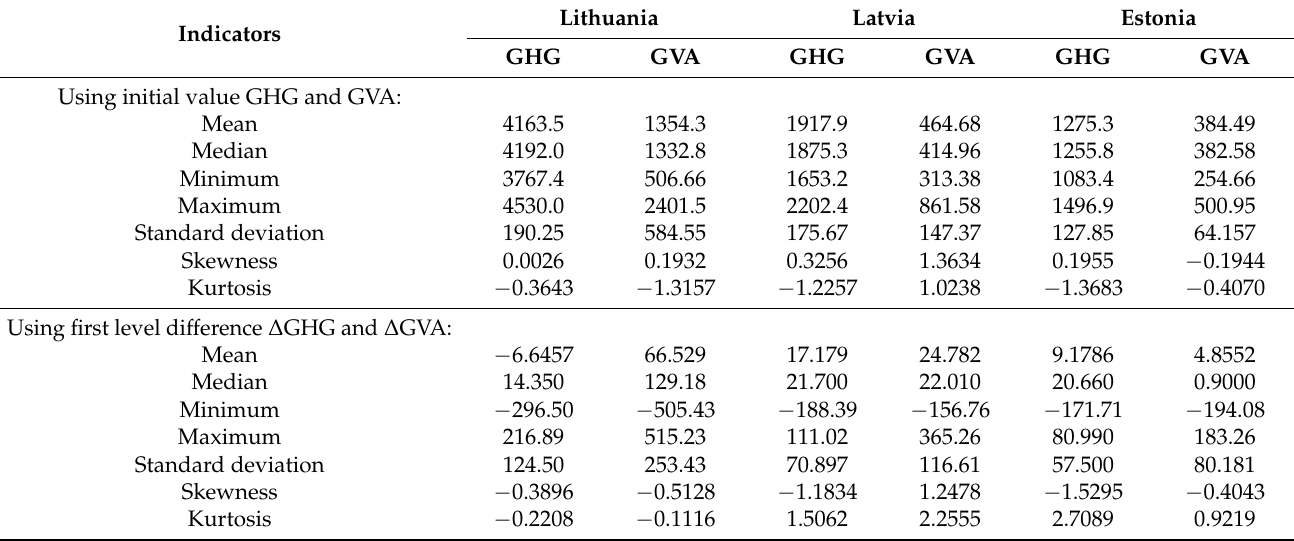
Source: authors’ calculations based on Eurostat [9,70] data, 2022.